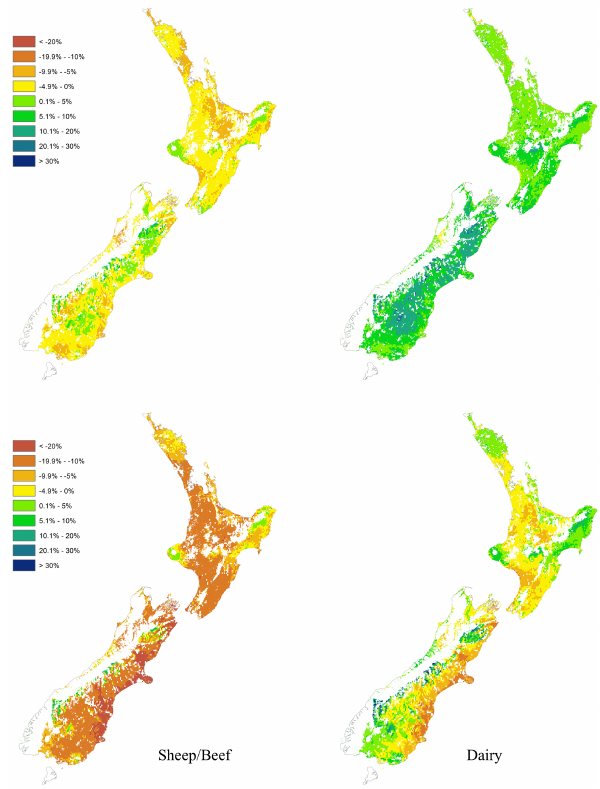
Figure 8. Climate change 2050 MPI (top) and GIEH (bottom) model scenarios, average annual total pasture production, percent- age change from baseline for sheep/beef (left) and dairy (right). Each map shows national pasture production as if all of the avail- able land (excluding urban and conservation land) were devoted to sheep/beef or dairy agriculture systems and is not an actual repre- sentation of current or projected land use.